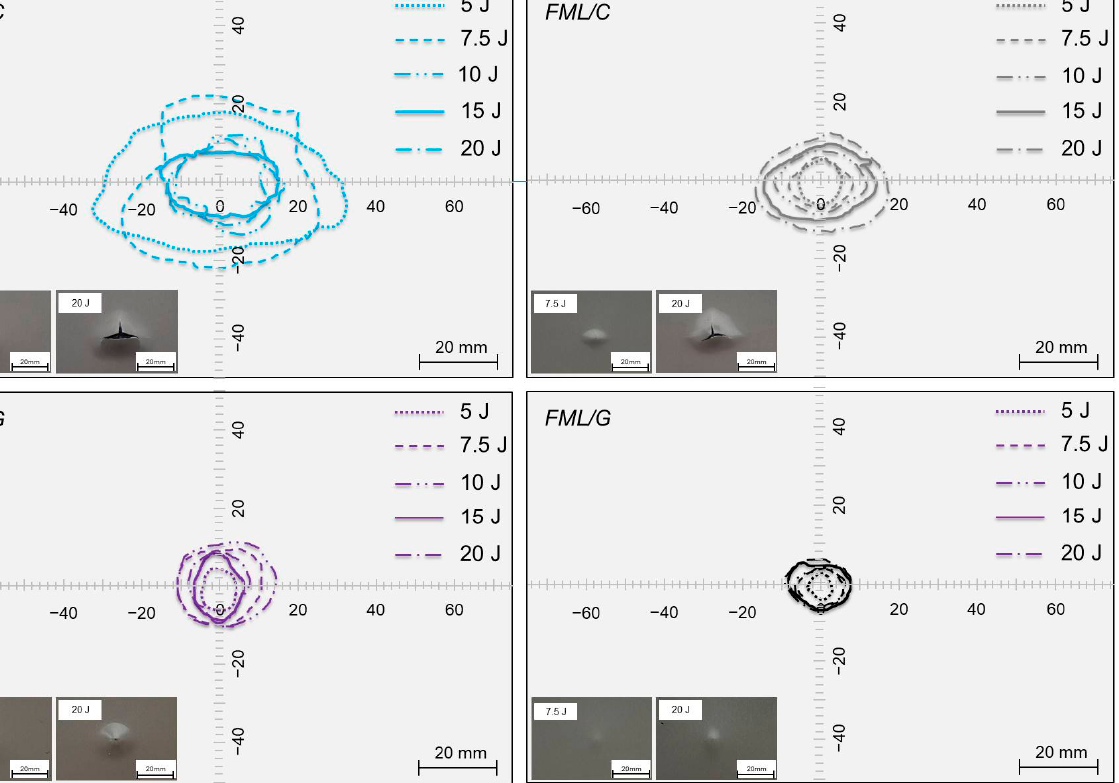
Figure 9. Damage area and non-impacted side of FFLs and